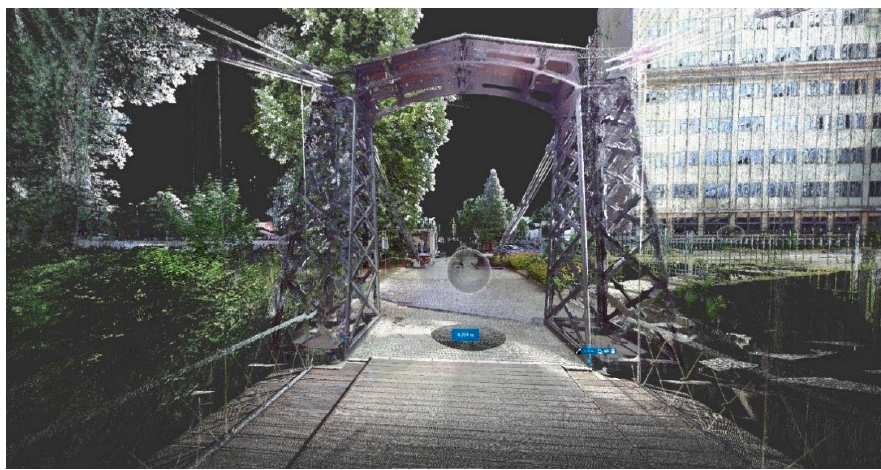
Figure 8. Spatial view of the connected point cloud (scanning session in the bridge middle).